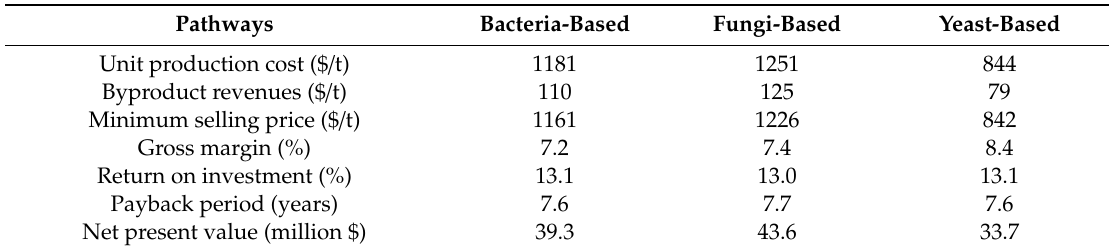
Table 5. Financial analysis for di ff erent lactic acid production